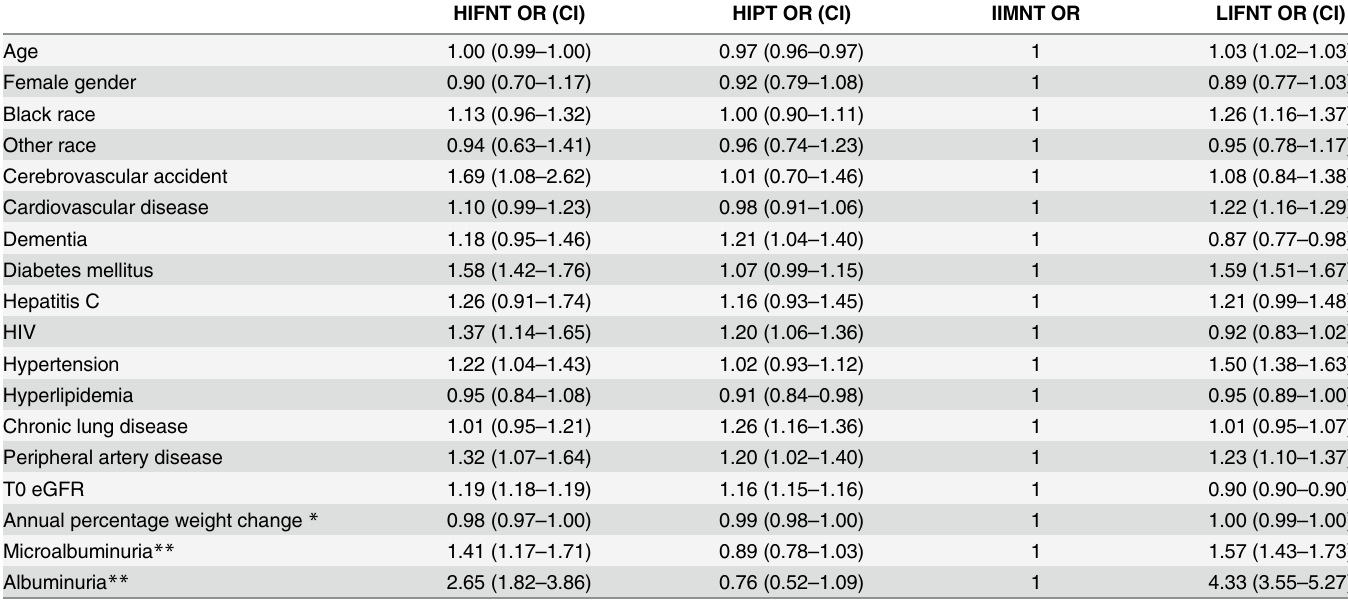
Table 6. Adjusted associations of trajectory phenotypes. HIFNT = High Intercept and Fast Negative Trajectory includes trajectory F. HIPT = High Inter- cept Positive Trajectory and includes trajectory A and B; IIMNT = Intermediate Intercept Mild Negative Trajectory and includes trajectory C, and D; LIFNT = Low Intercept Fast Negative Trajectory and includes trajectory E and G; Model adjusted for age, race, gender, for age, race, gender, diabetes melli- tus, hypertension, cardiovascular disease, hyperlipidemia, peripheral artery disease, cerebrovascular disease, chronic lung disease, hepatitis C, HIV, dementia, and eGFR at time of cohort entry (T0). Reference group is IIMNT.